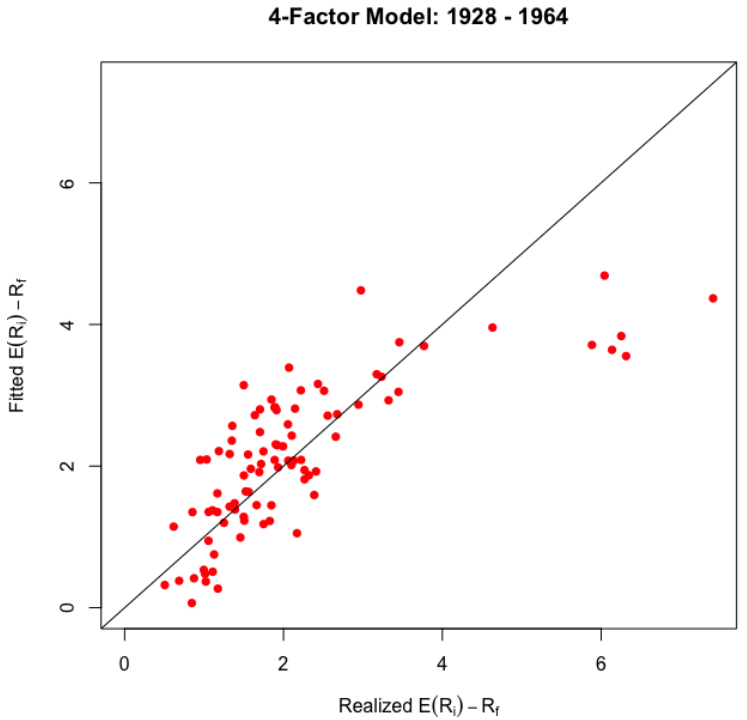
Figure 5. Out-of-sample cross-sectional relationships for the Fama and French four-factor model between average one-month-ahead fitted (predicted) excess returns in percent ( y -axis) and average one-month-ahead realized excess returns in percent ( x -axis): January 1928 to December